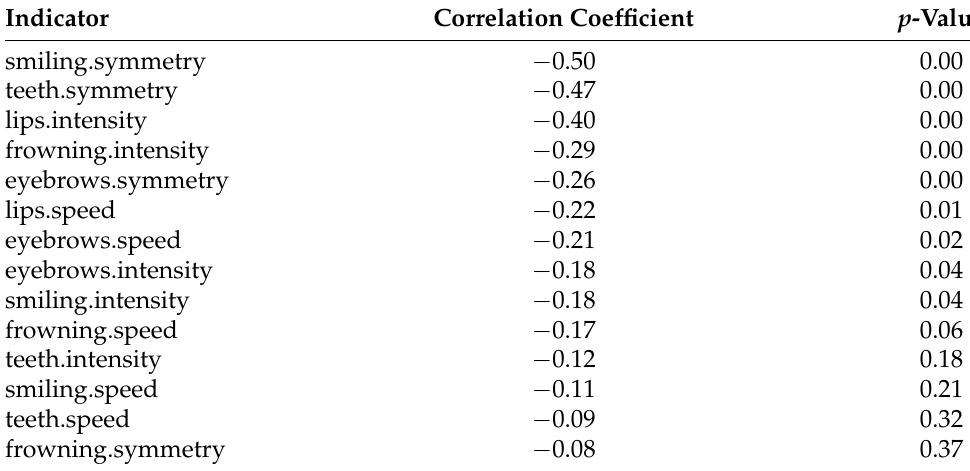
Table 8. Paired Spearman’s correlation between House–Brackmann (HB) grades and health scores for individual